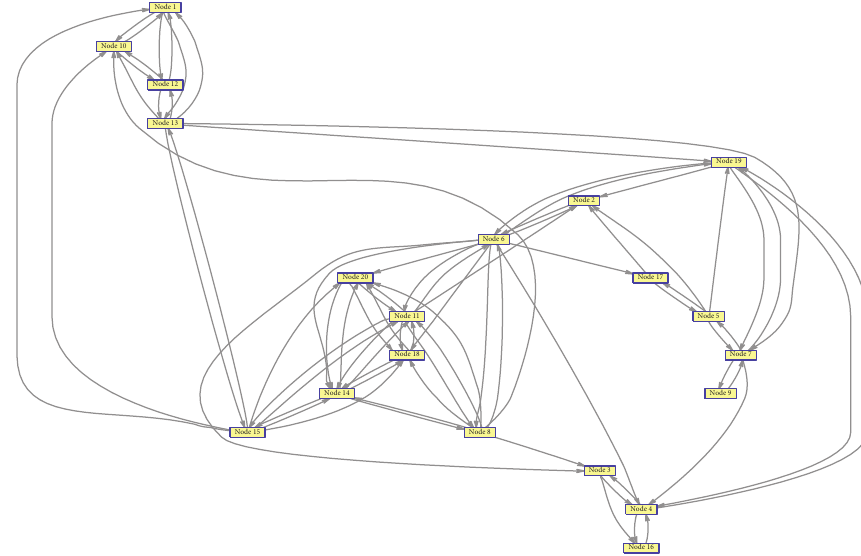
Figure 6: A 20-node strongly connected network with different transmission ranges.